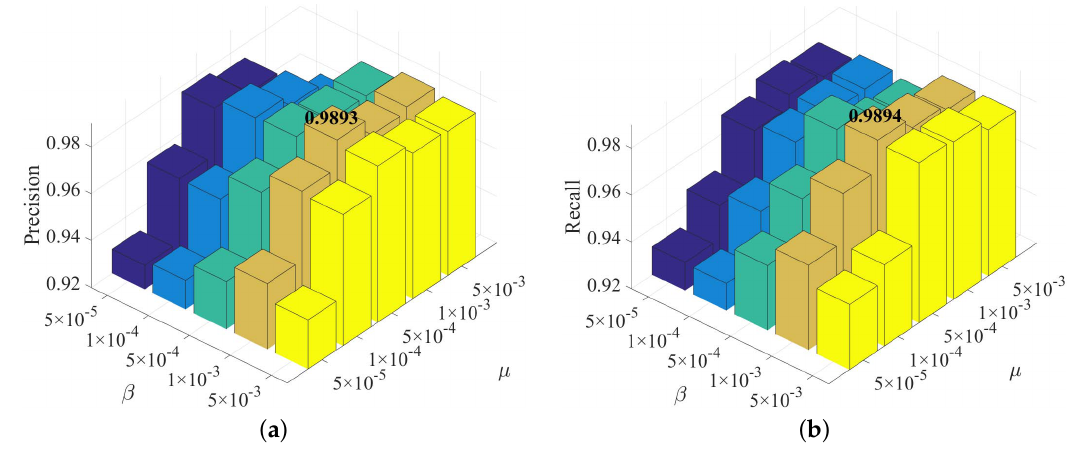
Figure 9. Ship-detection results of the LFNet measured in terms of precision and recall over ship and nonship classes under different parameter settings: ( a ) precision rate and ( b ) recall rate. The highest precision and recall rate values are indicated with bold numbers on their corresponding